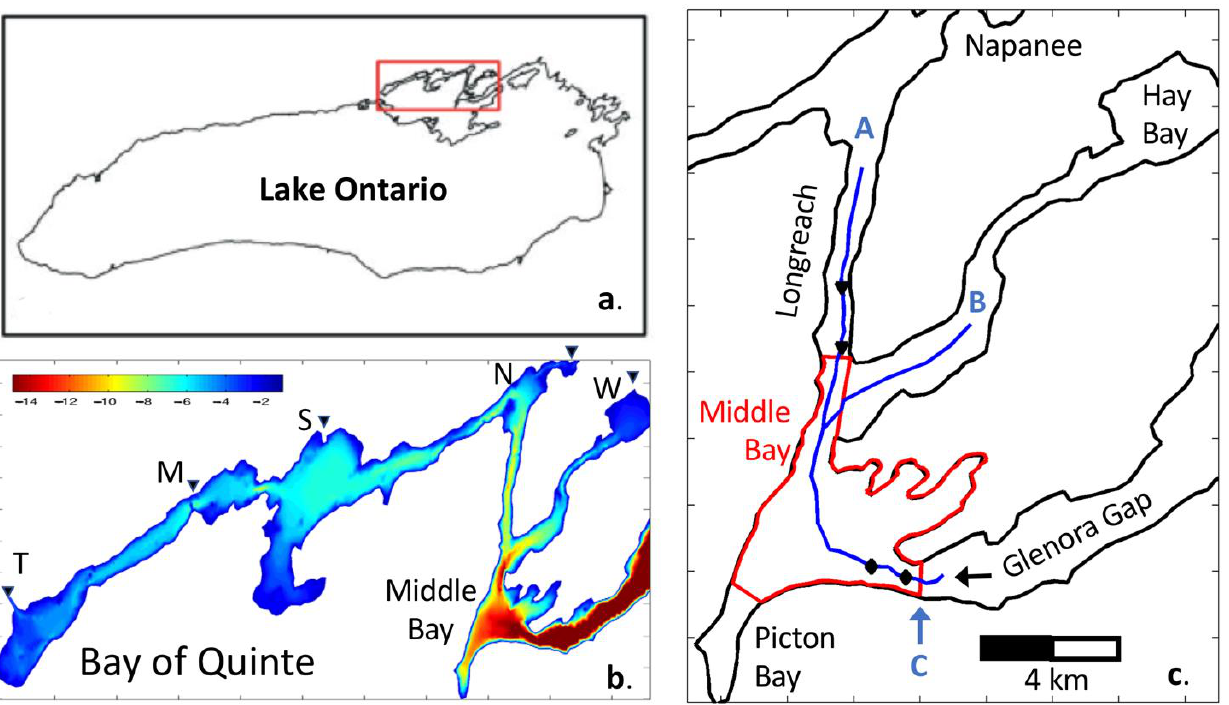
Figure 1. ( a ) Lake Ontario with Bay of Quinte (red box). ( b ) Bathymetry (m) of the Bay of Quinte with locations of five tributaries marked with triangles: Trent River (T), Moira River (M), Salmon River (S), Napanee River (N) and Wilton river (W). ( c ) Middle bay (red outline) between Longreach and the Glenora Gap and its two isolated embayments: Hay Bay and Picton Bay. Transect lines A and B marked in blue; transect line C crosses the Glenora Gap. Ends of the in situ temperature transects for Longreach and the Glenora Gap are marked with triangles and diamonds, respectively.